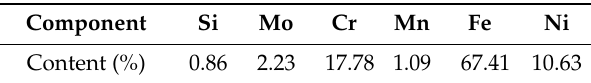
Table 1. Analysis results for SS316